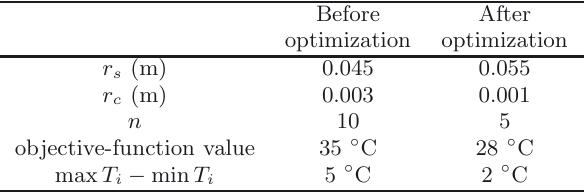
Fig. 15. Objective-function value versus iterations. Table 2. initial and optimal solutions.